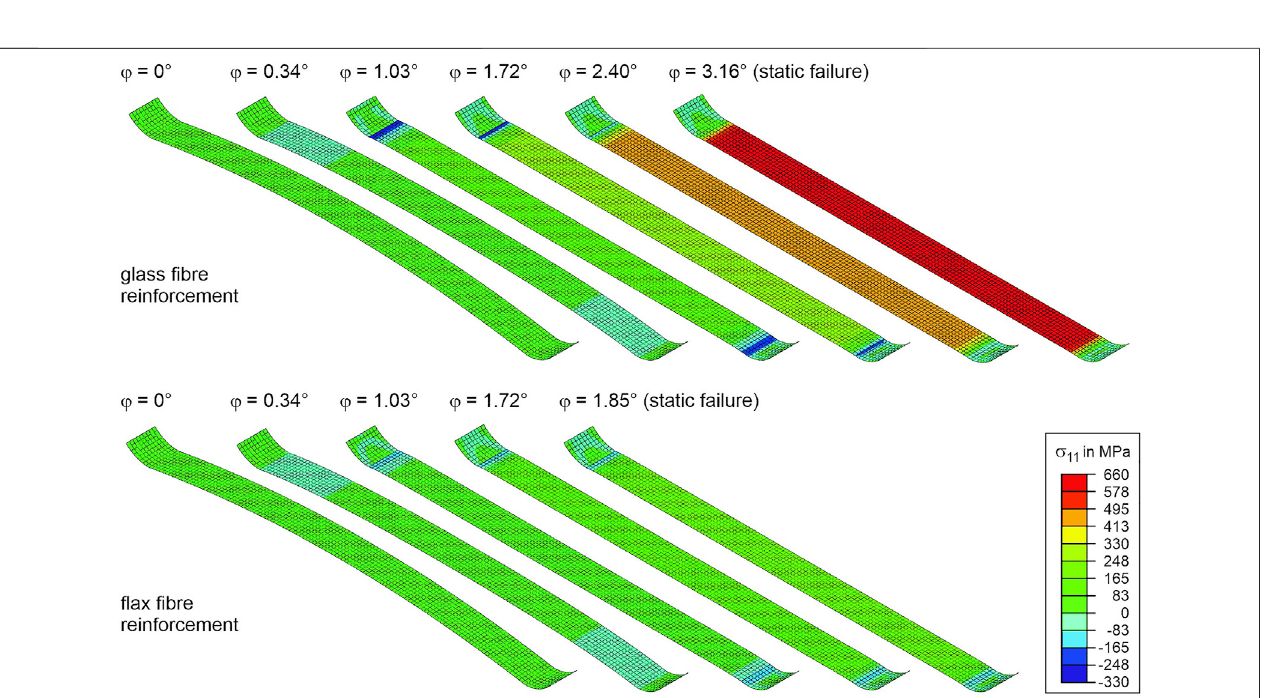
FIGURE 12 | Load (left) versus rotation angle characteristics (right) for the axle tie.